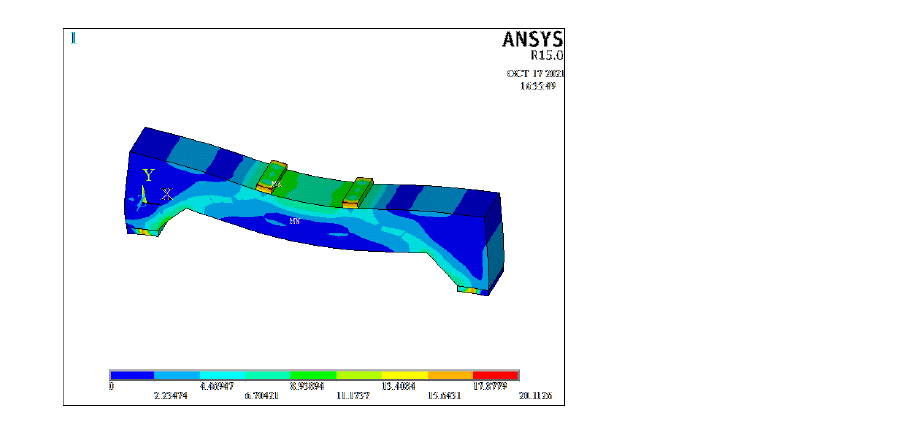
Figure 11. Contour of the von Misses stress for the typical non-prismatic RC beam model B1 (solid).